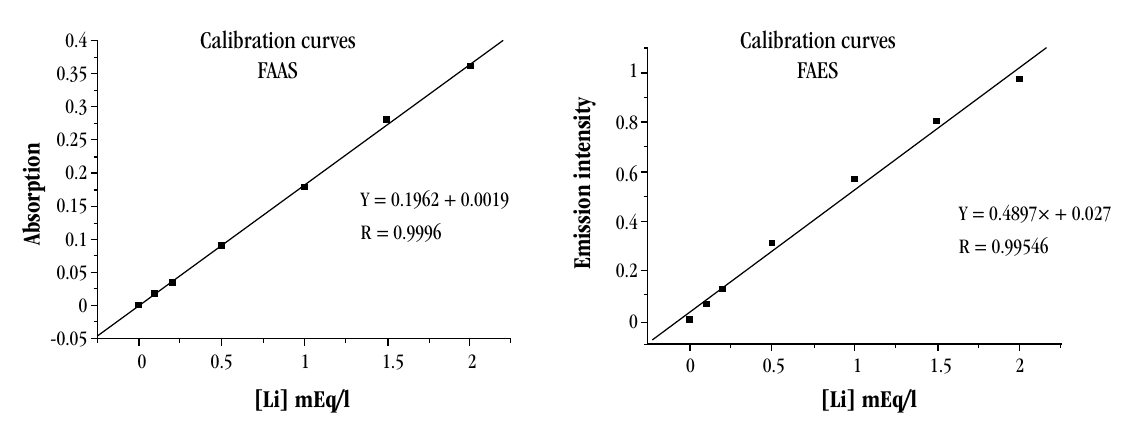
figurE 2 – Calibration curves in the concentrations from 0.05 to 2 mq/l lithium by techniques FAAS and FAES FAAS: flame atomic absorption spectrometry; FAES: flame atomic emission spectrometry. .